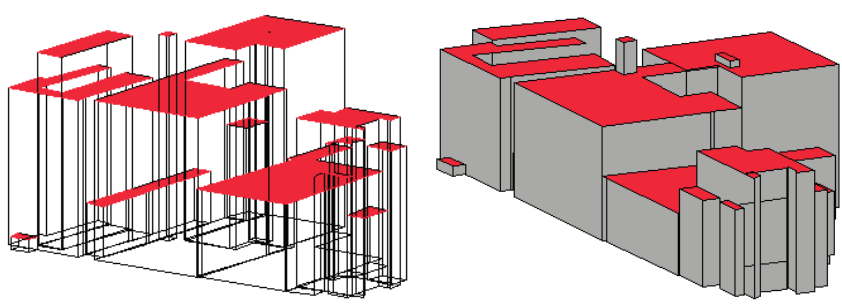
Figure 10. Building model generation: wireframe model and solid model. Roofs are represented by the red